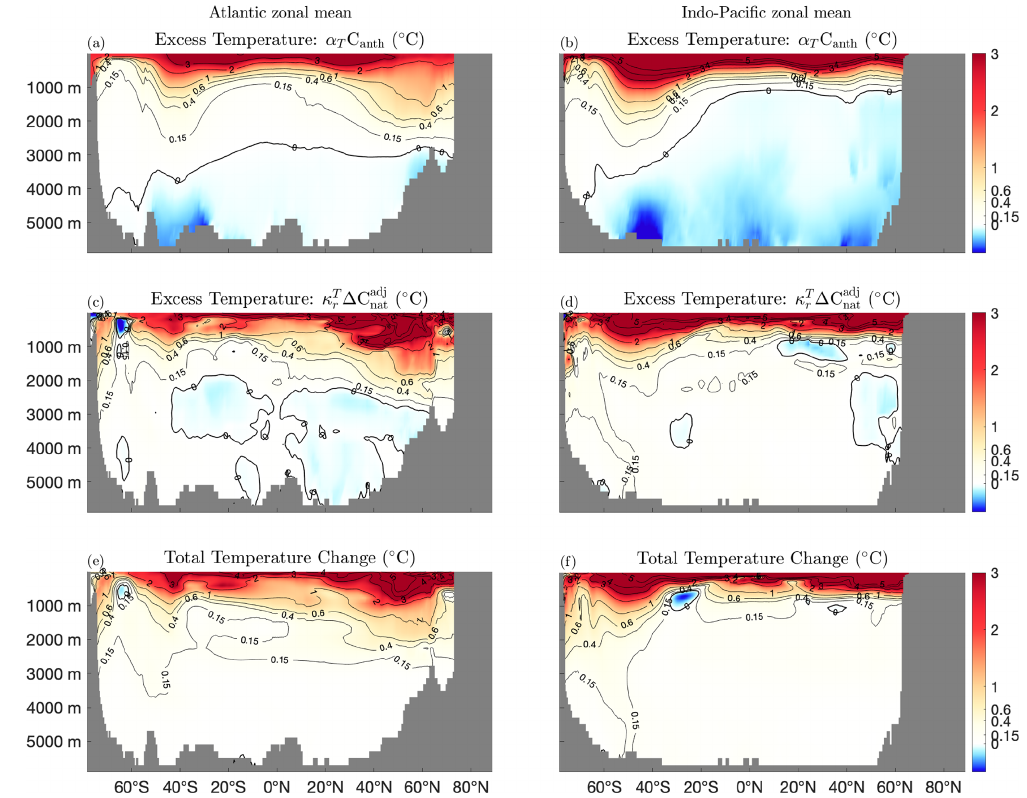
Figure 2. Atlantic and Indo-Pacific zonal, decadal mean excess temperature estimates for the decade 2090–2099 and total temperature change. The method of Bronselaer and Zanna (2020) is shown in panels (a and b) , our method in panels (c and d) , and the total temperature change in panels (e and f) . The thick black contour indicates the zero contour, and temperature changes are indicated by thin contours, which are also indicated on the colour